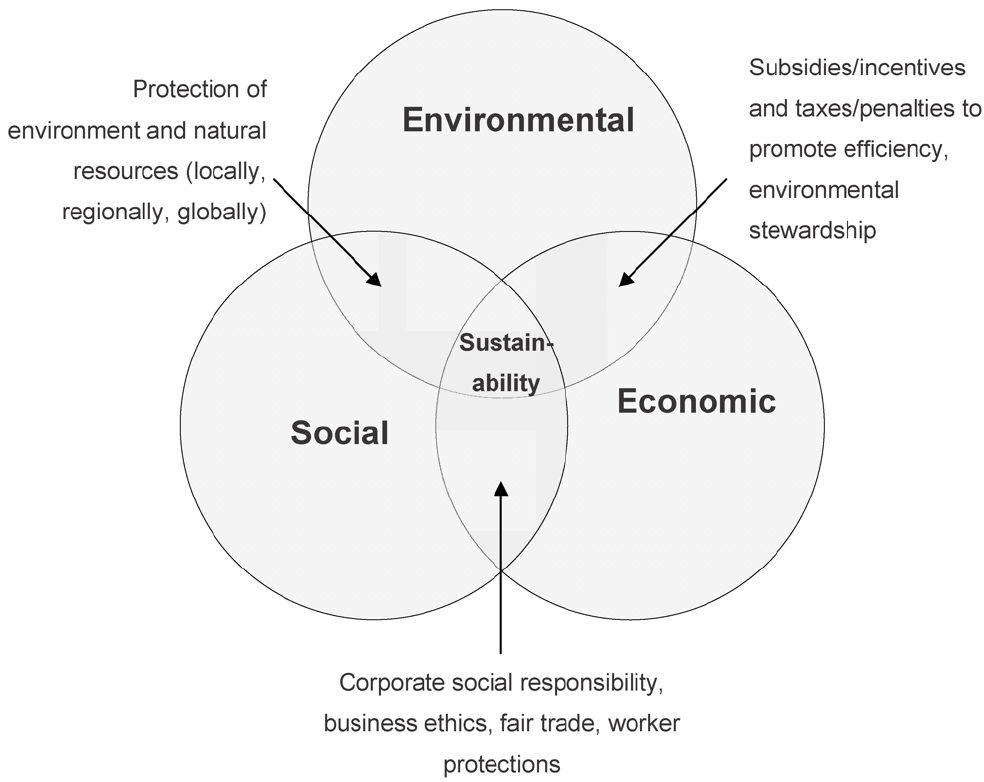
Figure 1. Sustainable manufacturing concept [4].